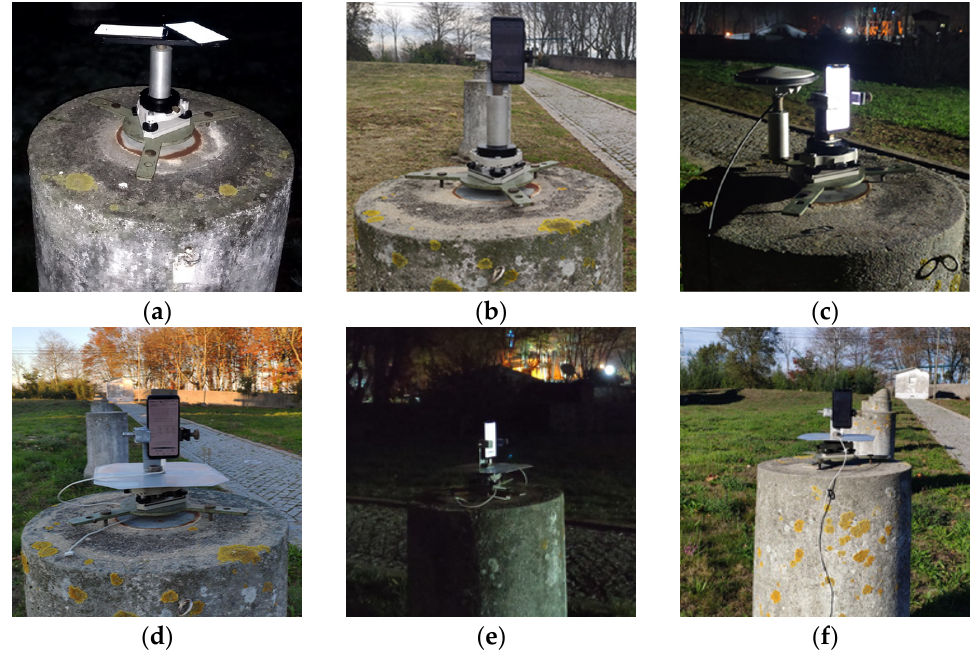
Figure 3. Test 1 with smartphones A and B ( a ); Tests 2 ( b ), 4 ( d ), 5 ( e ) and 6 ( f ) with smartphone A; Test 3 with smartphone A and PolaNt-MF antenna ( c